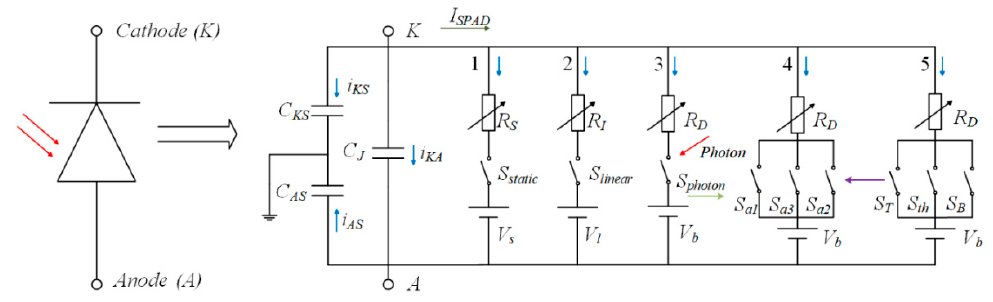
Figure 2. Analytical model of an InP/InGaAs SPAD.